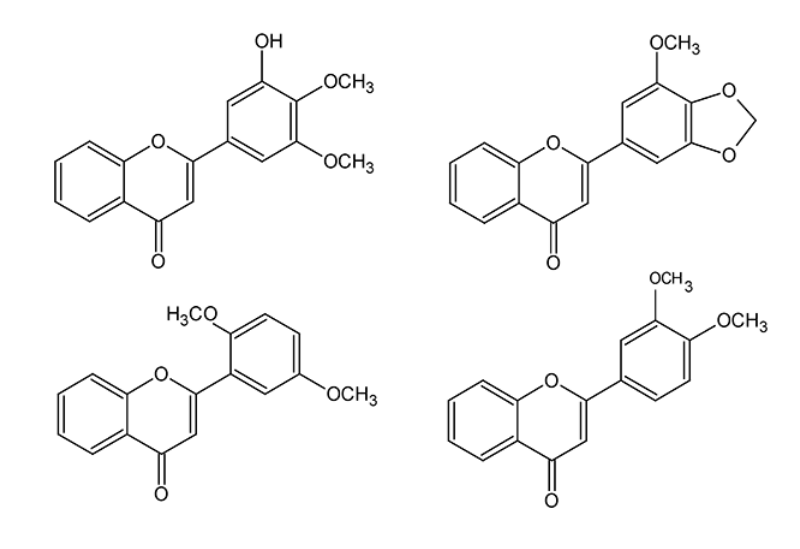
Figure 10 New nature lipophilic flavones in in vitro propagated Primula veris .